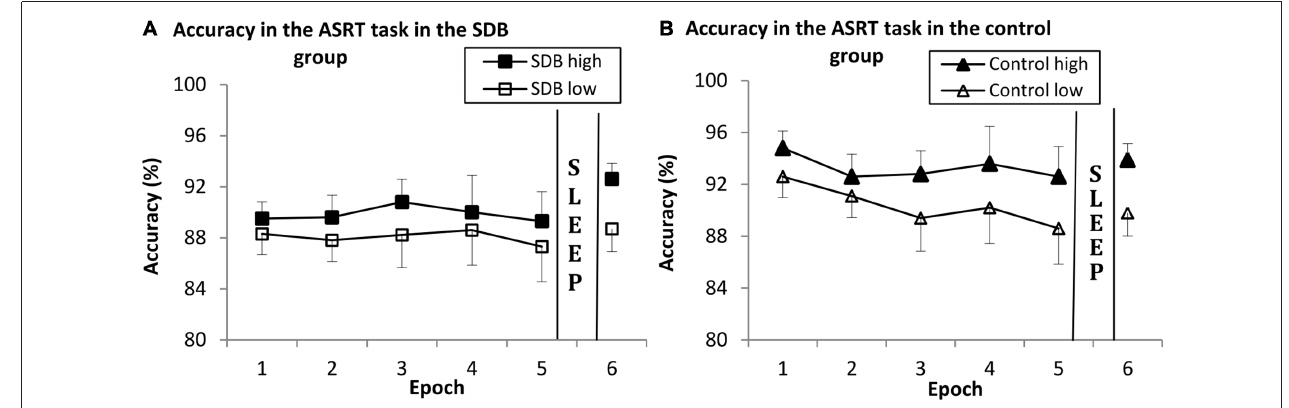
FIGURE 2 | Results of sequence-specific and general skill learning in the SDB (A) and control group (B) in Session 1 (Epoch 1–5) and Session 2 (Epoch 6) on accuracy measures. Both groups showed significant sequence-specific and general skill learning. There were no differences in learning and in offline changes between the groups; the pattern of learning was similar in the SDB and control groups. Error bars indicate SEM.